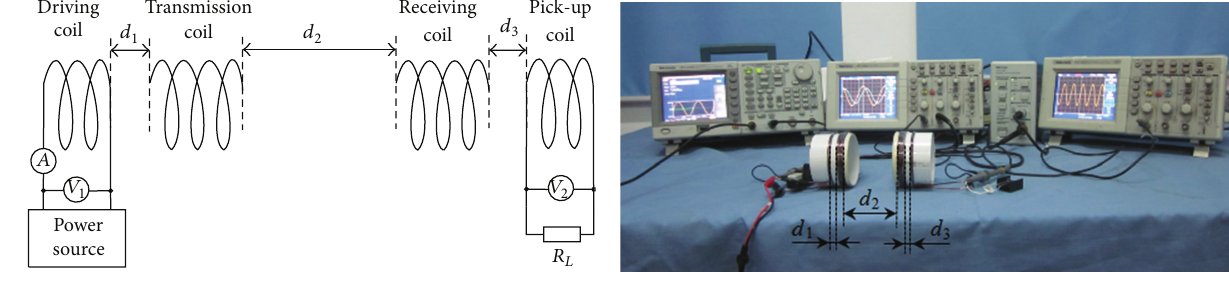
Figure 4: Experimental system.